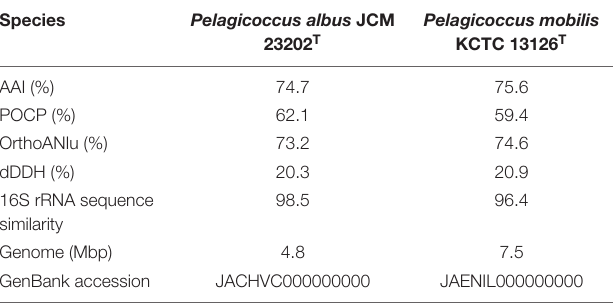
TABLE 2 | The genome-to-genome distance between strain NFK12 T and the phylogenetically related strains.